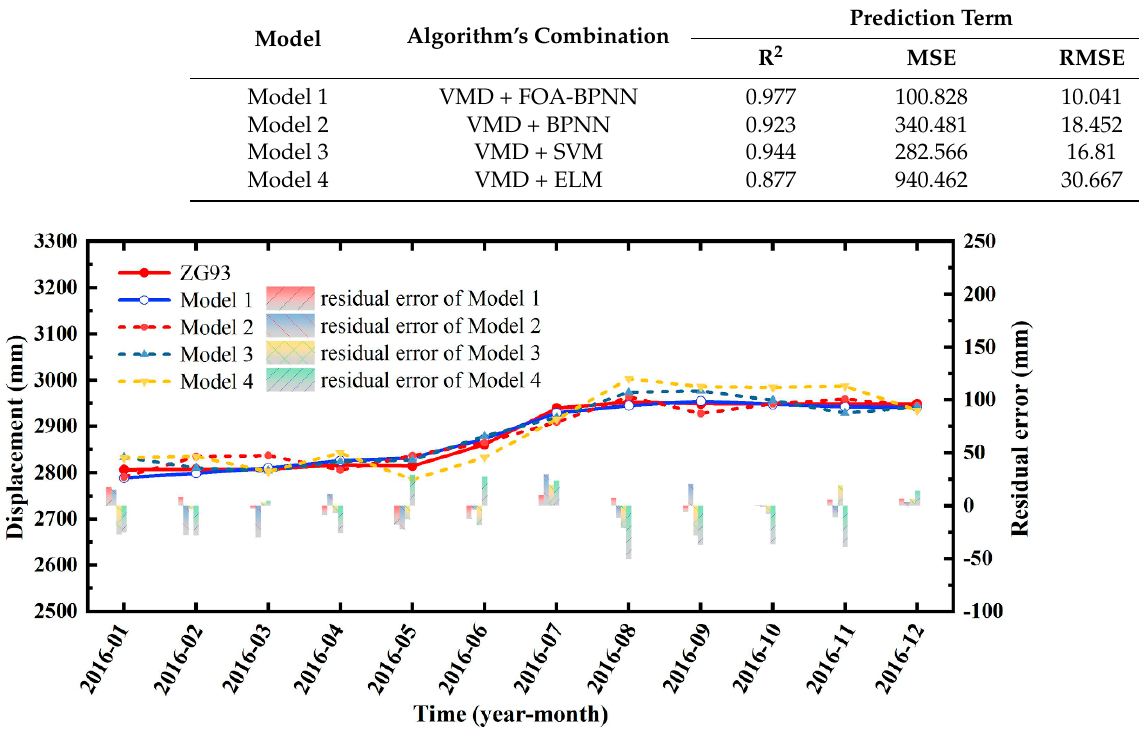
Figure 17. Prediction curves of the total displacement.